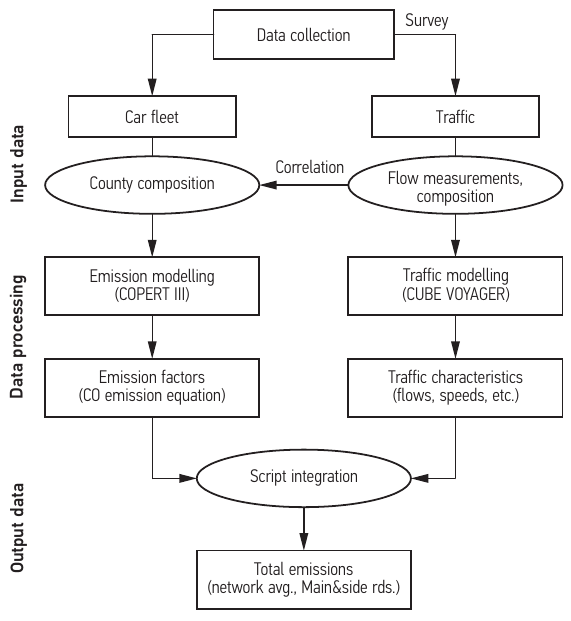
Fig. 1. Modelling approach